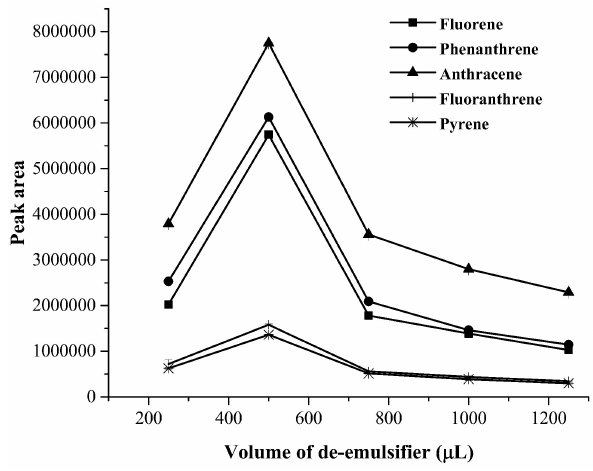
Figure 5. Effect of volume of de-emulsifier solvent on the extraction